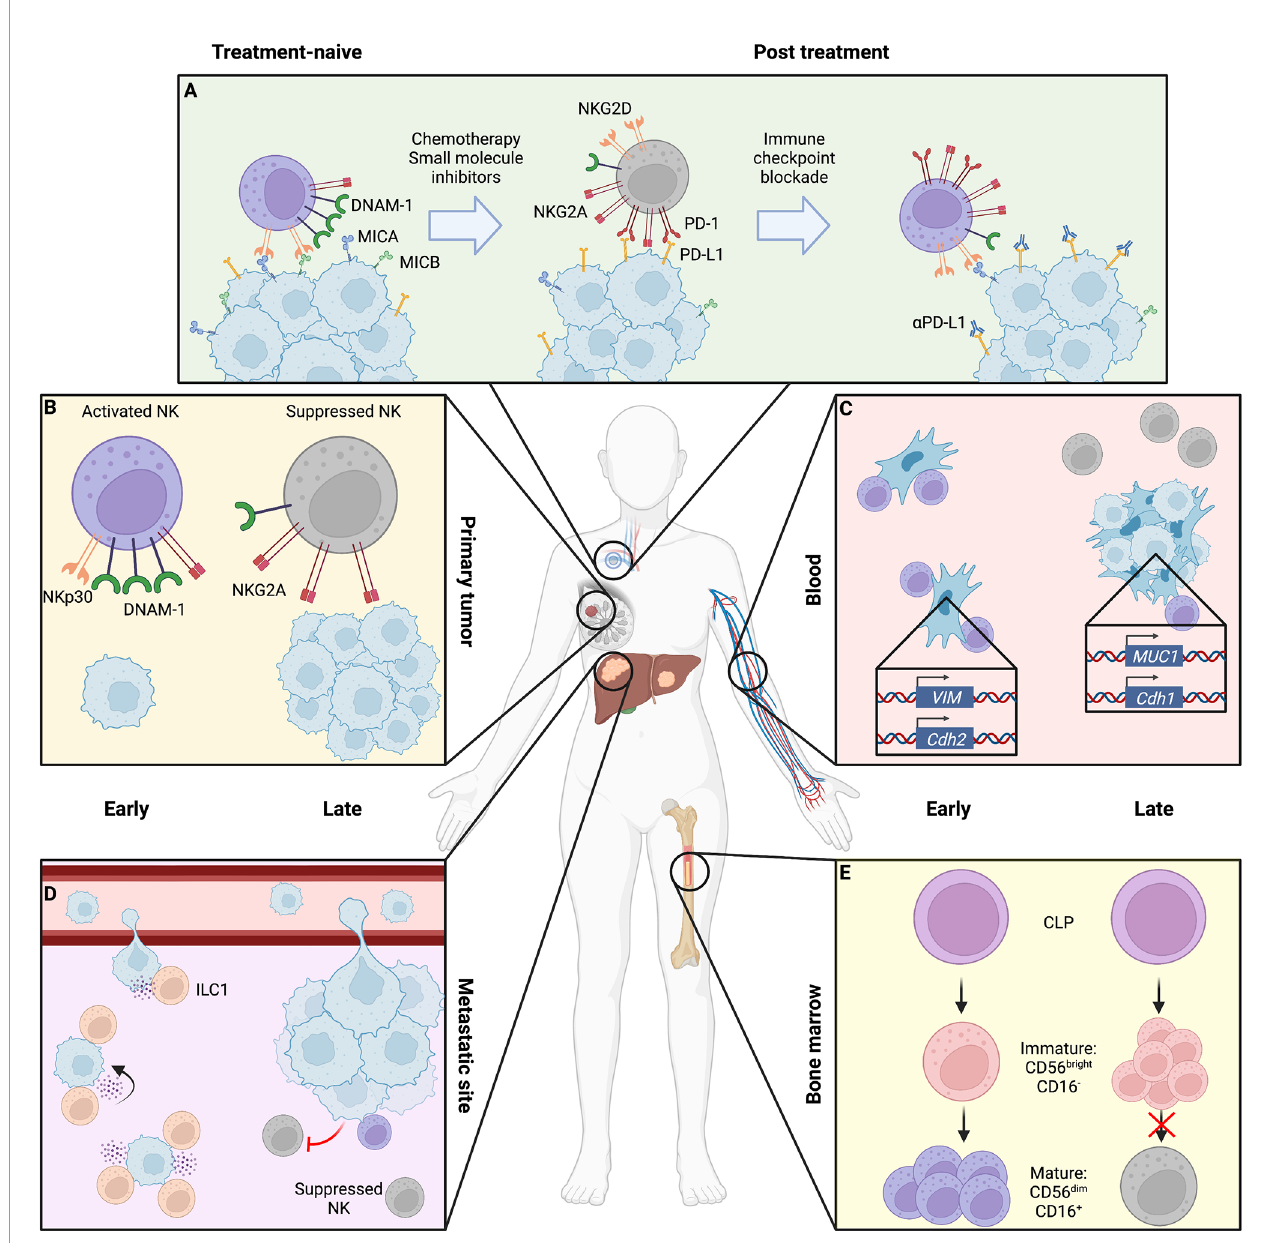
FIGURE 1 | Location- and stage-dependent changes in NK cell status and function. Magni fi ed bubbles represent cancer therapy (A) , primary breast tumor (B) , peripheral blood with circulating tumor cells (CTCs) (C) , liver metastasis (D) , and bone marrow niche (E) . (A) During treatment, cytotoxic chemotherapy and small molecule inhibition can induce NK cell resistance through downregulation of NK activating ligands and upregulation of immune checkpoint molecules on the tumor surface, coupled with a shift in NK cell receptor repertoire toward inhibitory signaling. These may be overcome by sequential immune checkpoint blockade to release suppressed NK cells. (B) The late-stage primary tumor induces immunosuppressive changes in NK cells, causing reduced expression of activating receptors like DNAM-1 and NKp30 as well as cytotoxic effector molecules perforin and granzyme, while upregulating inhibitory receptors such as NKG2A. (C) In the blood, early- stage CTCs that have fully undergone epithelial-to-mesenchymal transition (EMT) expressing N-cadherin and vimentin are ef fi ciently targeted by NK cells which are overcome by NK-suppressive mixed epithelial-like CTCs retaining mucin or E-cadherin expression in late disease. (D) At metastatic sites, ILC1s and NK cells may cooperate to respectively inhibit metastatic seeding and kill tumor cells within established lesions, though by late disease cytotoxic cells are suppressed toward an immature, dysfunctional state. (E) NK maturation in the bone marrow niche may be suppressed by tumor presence, arresting NK cells in an immature state. Created using